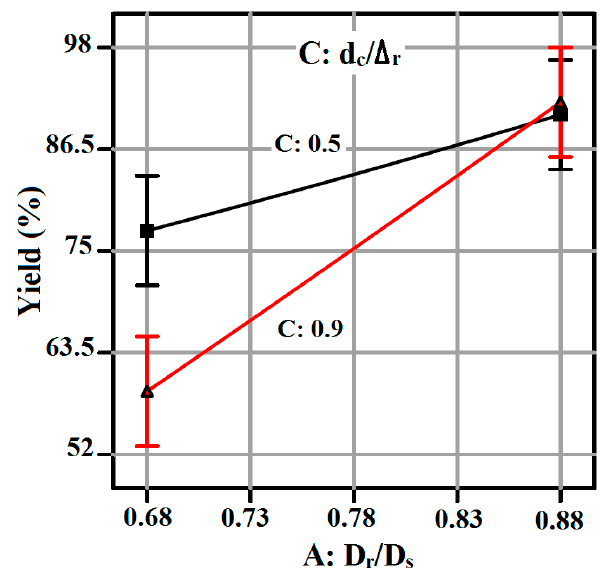
Figure 6. Interaction of rotor diameter to stator diameter ( Dr/Ds ) and ratio of cavity depth to the interval of rotor-stator ( dc/ ∆ r ) on the biodiesel yield.